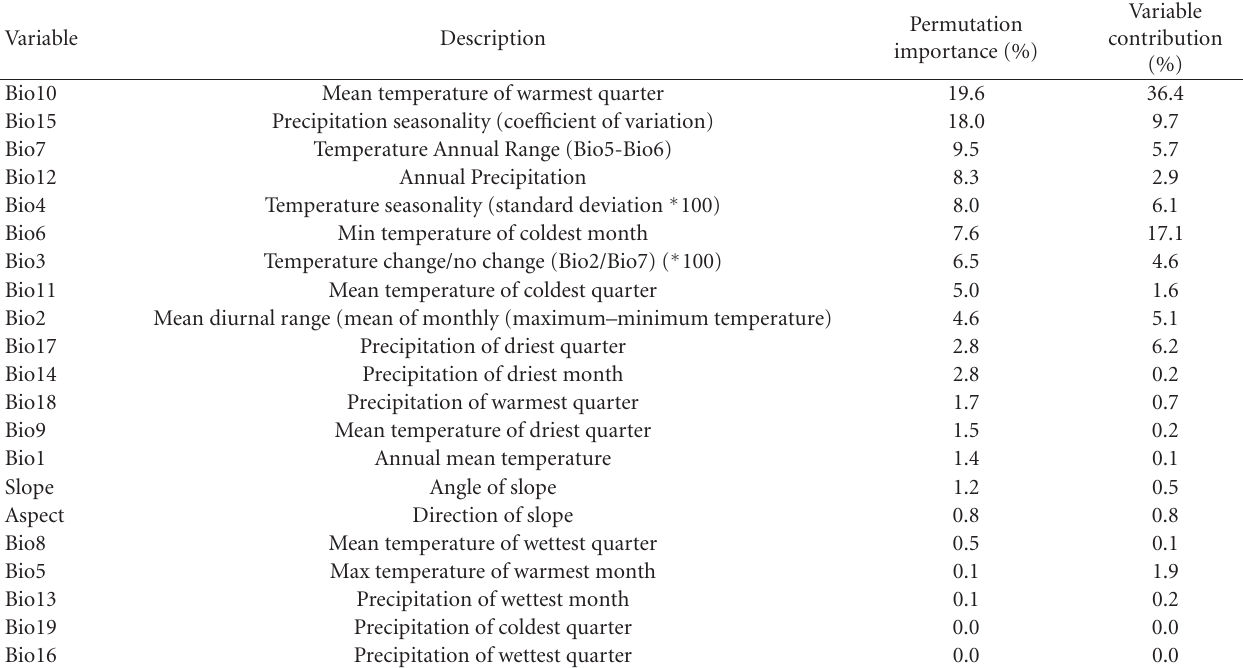
Table 1: Bioclim variables and their percent contribution and percent permutation importance reported by Maxent. Variables are in order of highest to lowest permutation